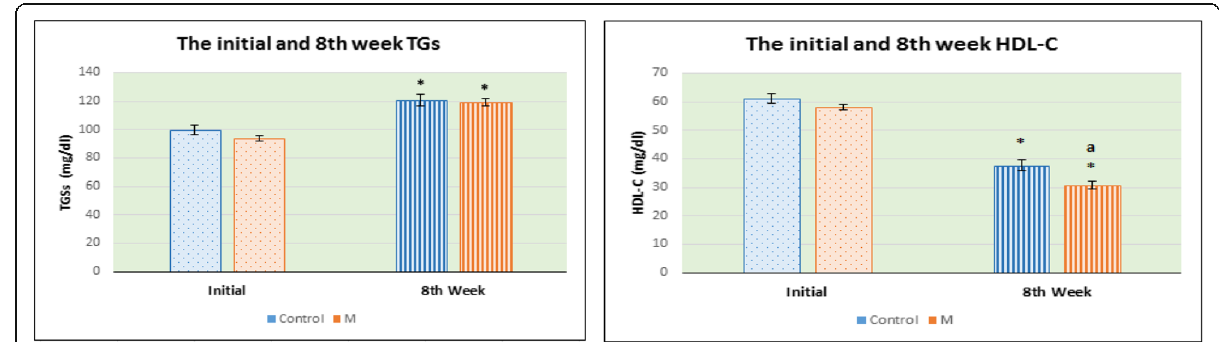
Fig. 2 The initial and 8 th week lipid parameters, in control and metabolic syndrome groups. M metabolic syndrome group, TGs triglycerides, HDL - C high density lipoprotein cholesterol. Data are expressed as mean ± SEM. * Significance from initial value, by Student ’ s “ t ” test for paired data, at P ≤ 0.05. a: Significance from control group, by Student ’ s “ t ” test for un-paired data, at P ≤ 0.05